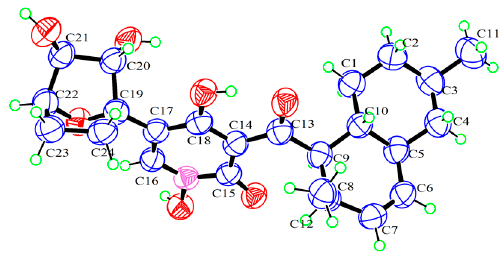
Figure 3. ORTEP drawing of 1.